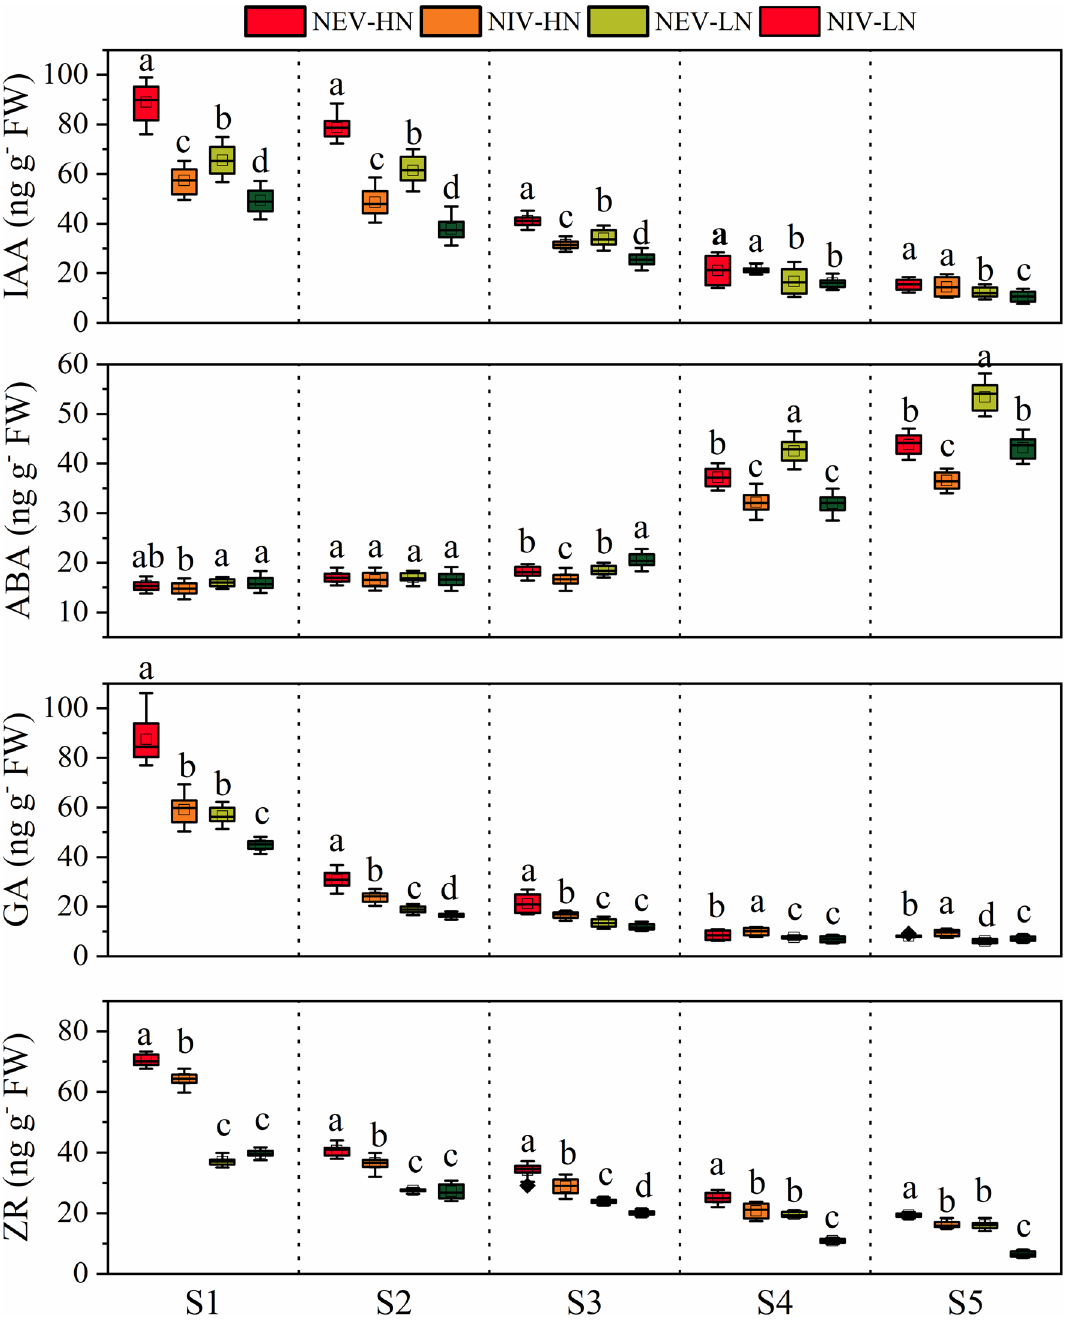
Figure 5. The IA, ABA, GA and ZR of ear during critical ear differentiation stages. Result is the average from 2018 to 2019. NEV-HN NEVs under high nitrogen conditions, NIV-HN NIVs under high nitrogen